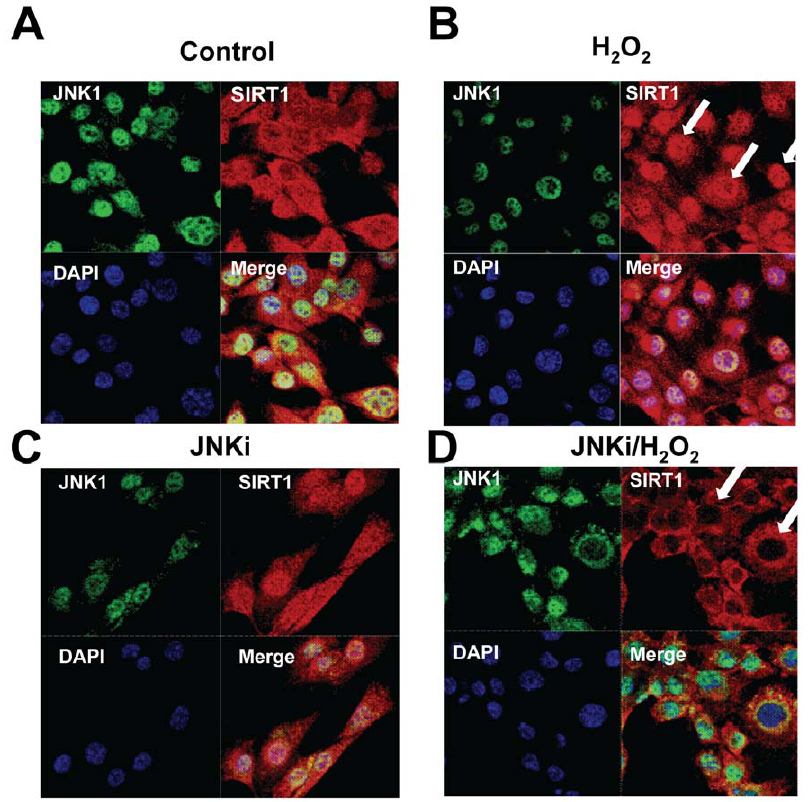
Figure 2. JNK1 regulates cellular localization of SIRT1. Immunohistochemistry of SIRT1 and JNK1. Cells were treated with control ( A ), H 2 O 2 ( B ), JNKi ( C ) or H 2 O 2 plus JNKi ( D ). Cellular localization of JNK1 was determined by anti-rabbit JNK antibody and SIRT1 by anti-mouse SIRT1 antibody. Cells were stained with DAPI stain to visualize nuclei. Arrows show SIRT1 localization.